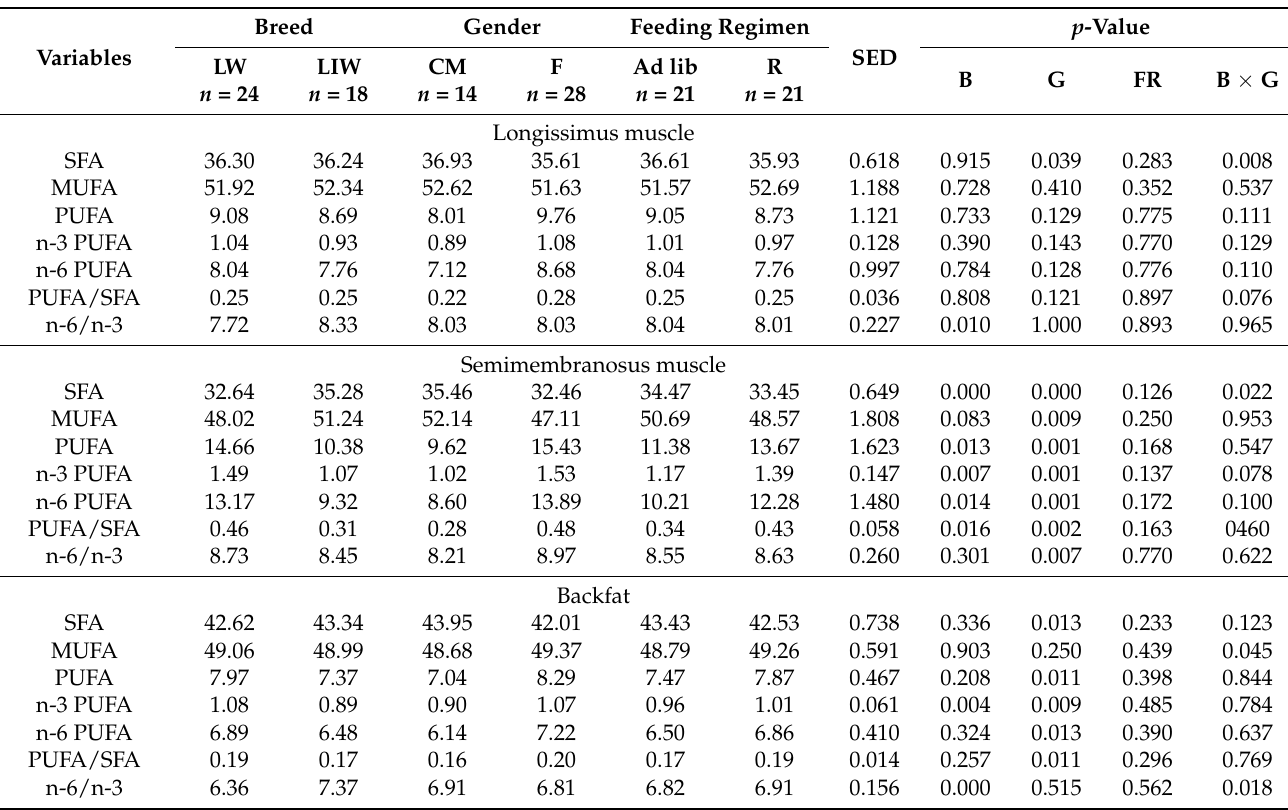
Table 7. Total saturated, monounsaturated, polyunsaturated fatty acids (in %) and fatty acid ratios in intramuscular fat of muscles and